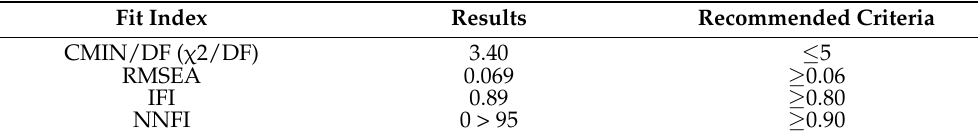
Table 6. Goodness-of-fit indices.